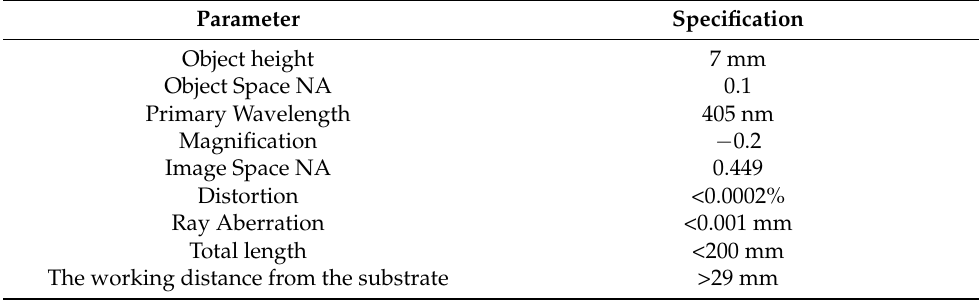
Table 1. Design specifications of projection lens for DMD-based maskless